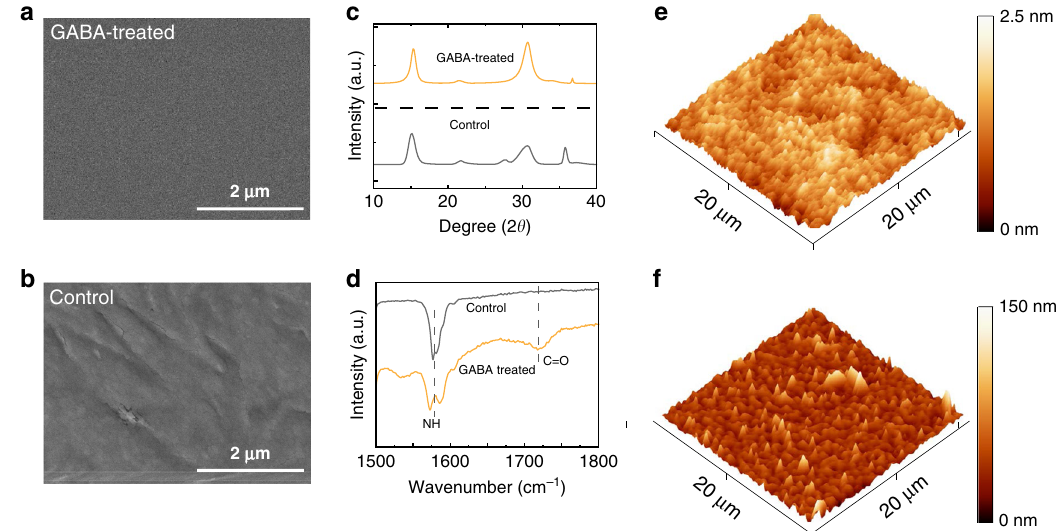
Fig. 3 Structural and morphological properties of CsPbBr 3 QW perovskites. a , b Top-view scanning electron microscope (SEM) images of GABA-treated ( a ) and control ( b ) CsPbBr 3 QW fi lms. c Powder X-ray diffraction (PXRD) of control and GABA-treated CsPbBr 3 thin fi lms. d FTIR spectra of control and GABA-treated CsPbBr 3 QW fi lms. e , f Atomic force microscope (AFM) images of GABA-treated ( e ) and control ( f ) CsPbBr 3 thin fi lms.